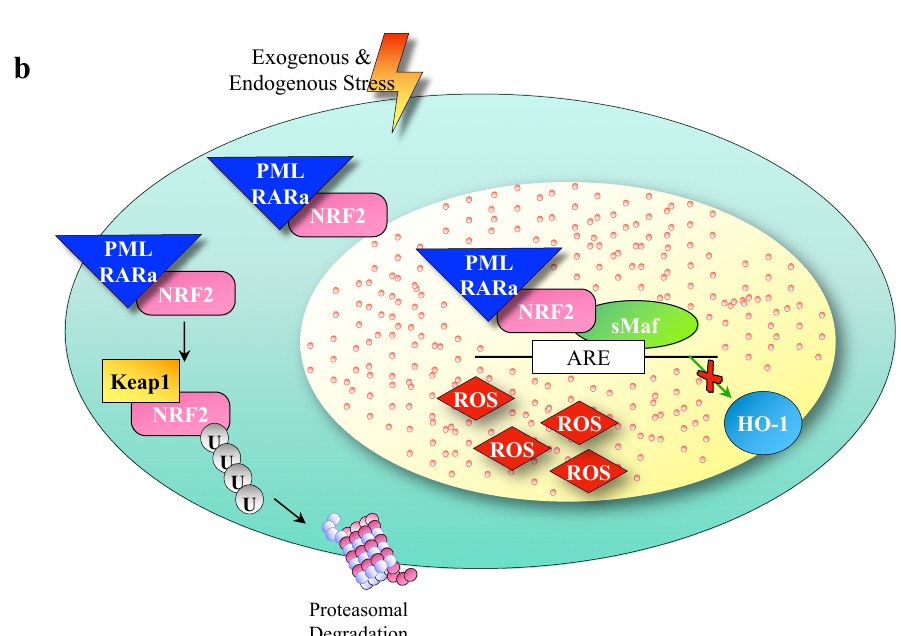
Figure5. AmodelofNF-E2p45-relatedfactor2(NRF2)deregulationbyPromyelocyticleukemia / retinoic